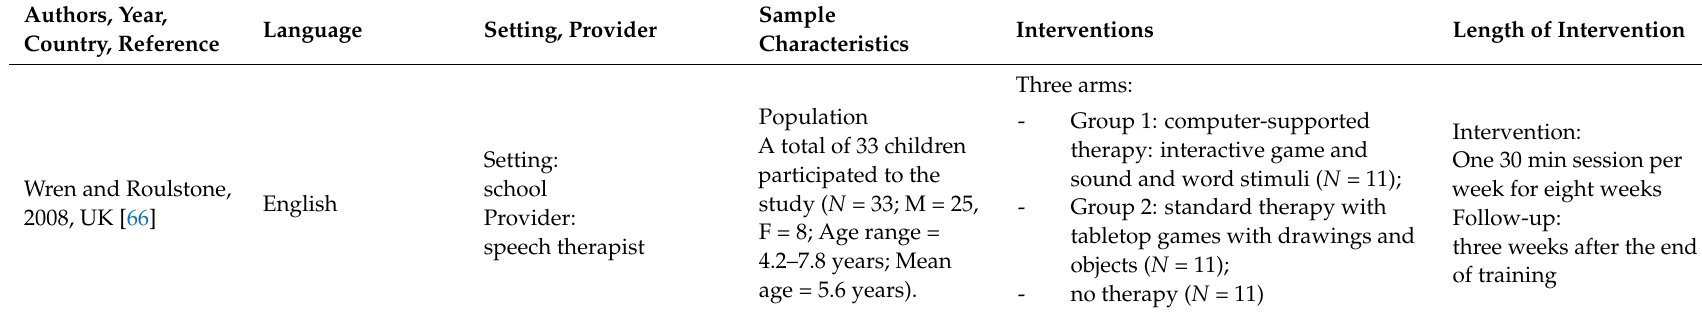
Phonologically based